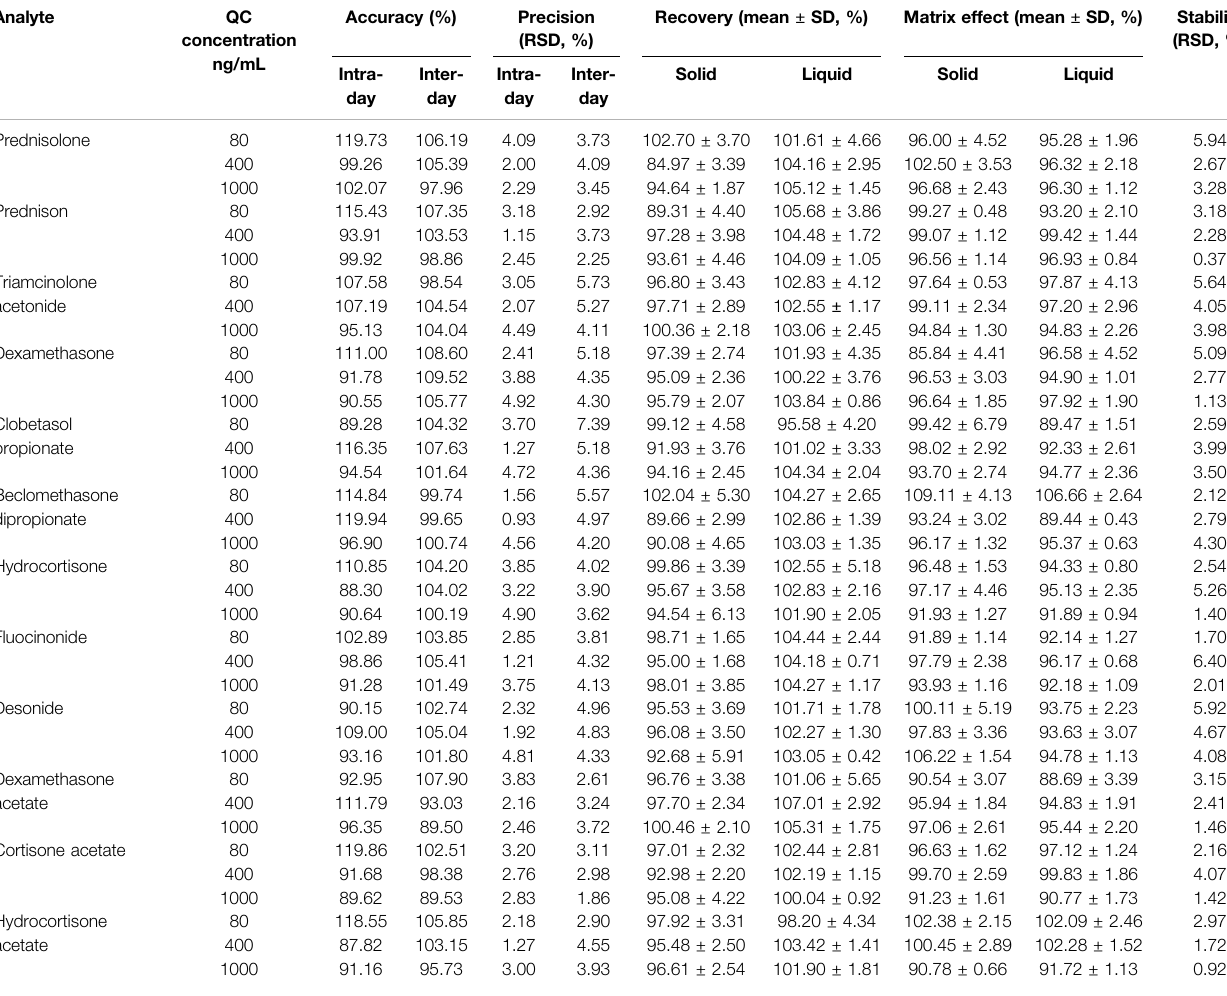
TABLE 2 | Accuracy, precision, recovery, matrix effect, and stability of 12 illegal adulterated glucocorticoids obtained by UHPLC-QTOF-MS. Analyte QC